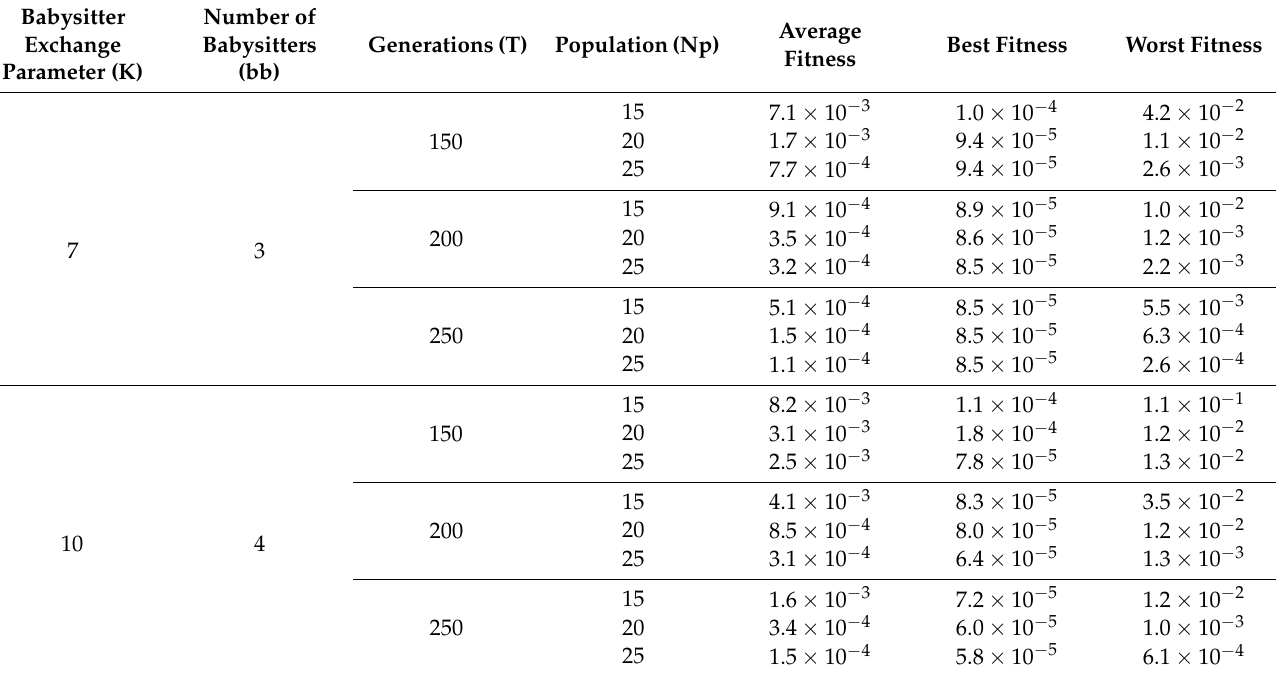
Table 1. DMOA analysis w.r.t. number of babysitters and babysitter exchange